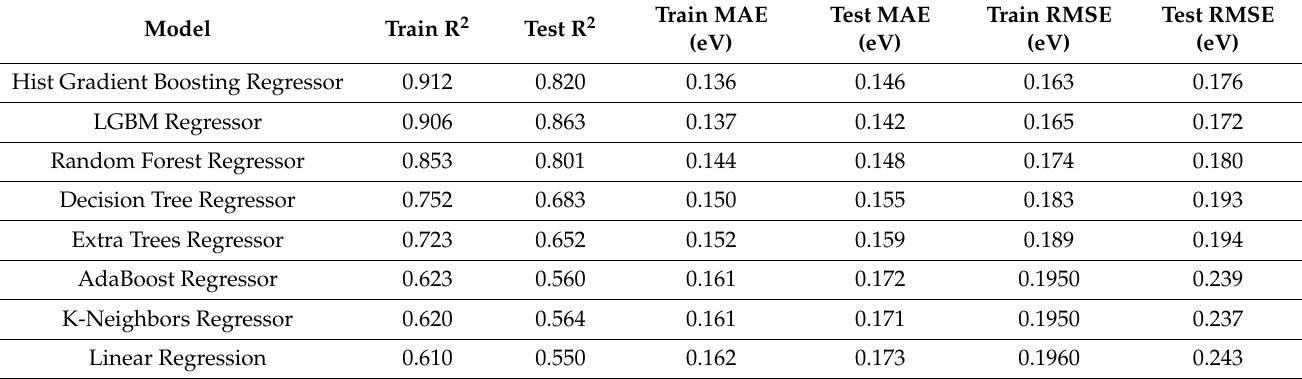
Table 2. R 2 , mean absolute error (MAE) and root mean square error (RMSE) values of various models for HOMO